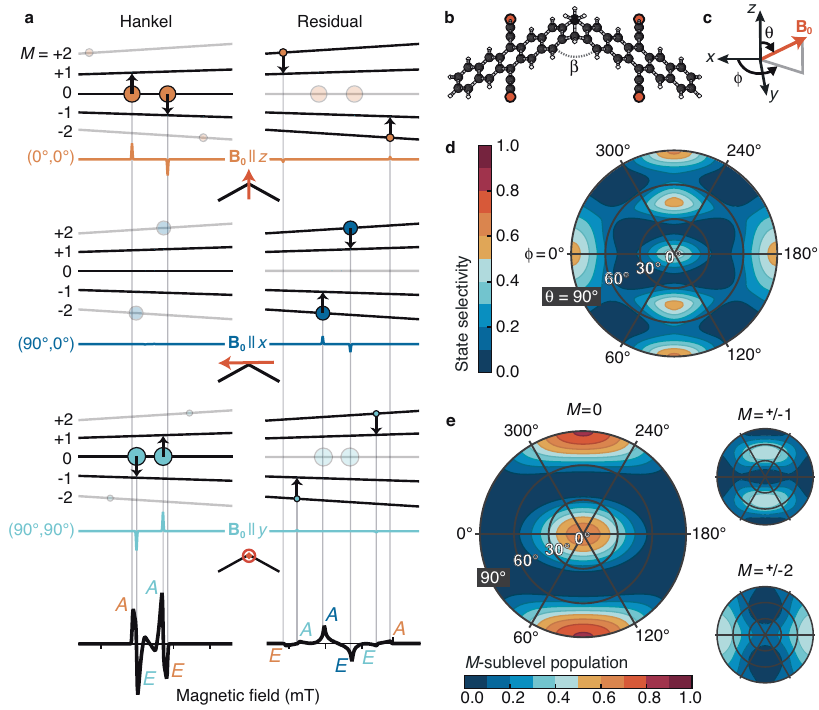
Fig. 3 | Theory predicts strong state selectivity for the rigid TIPS-BP1' dimer. a Fixed-orientation EPR spectra (colored lines) for B 0 (red arrows) applied along cardinal dimer directions. Predictions for the Hankel spectrum ( 5 TT 0 ↔ 5 TT ±1 ) on leftandresidualspectrum( 5 TT ±1 ↔ 5 TT ±2 )onright.Areaofcoloredcirclesindicates 5 TT M -sublevelpopulations,whichareshowntranslucentiftheydonotappearinthe correspondingspectrum.Arrowsshowthedirectionoftransitions( A absorptionor E emission). Vertical lines correlate population assignments with features in the simulatedpowderspectra(black,below). b ThetwochromophoresintheTIPS-BP1'